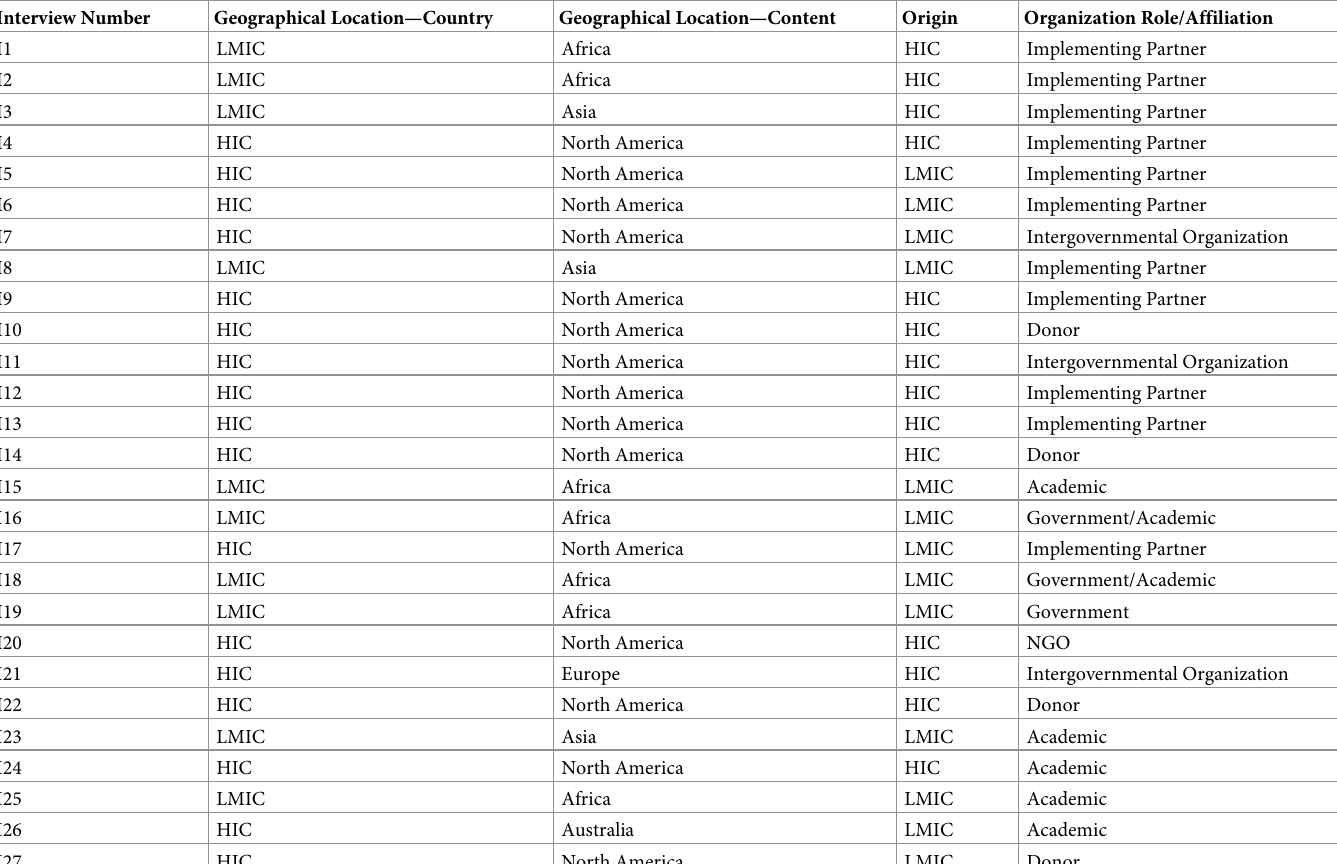
Table 1. Location, origin and organizational roles of interviewees. Interview Number Geographical